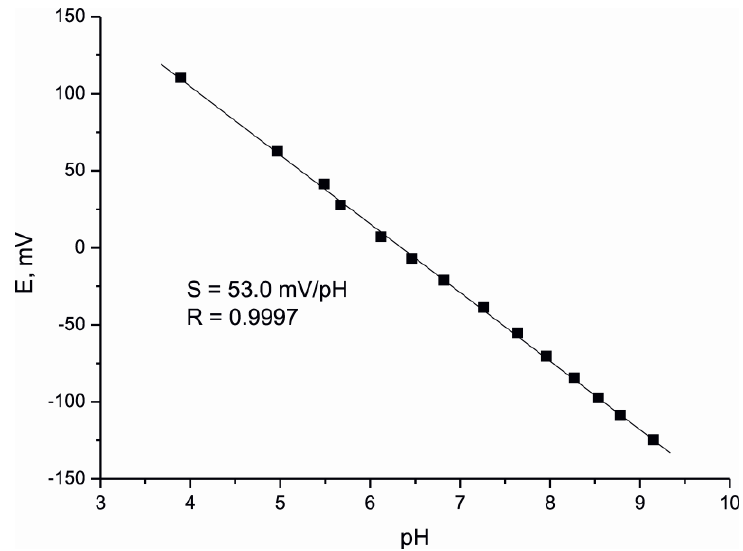
Figure 4. Calibration curve for pH electrode (mean of the values for 3 sensors).